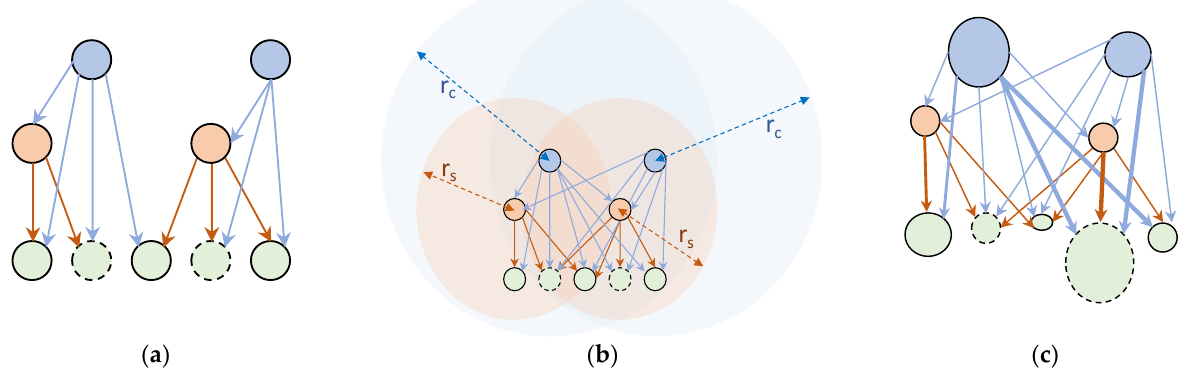
Figure 3. An illustrative example shows the two improvements introduced in the graph building (service redundant and weighted graph): ( a ) non-redundant and unweighted graph (each node receives a service only from the closest providers); ( b ) redundant and unweighted graph (each node provides services to all the receivers within a radius r ); ( c ) redundant and weighted graph (to each link, the number of users that the link serves is assigned).